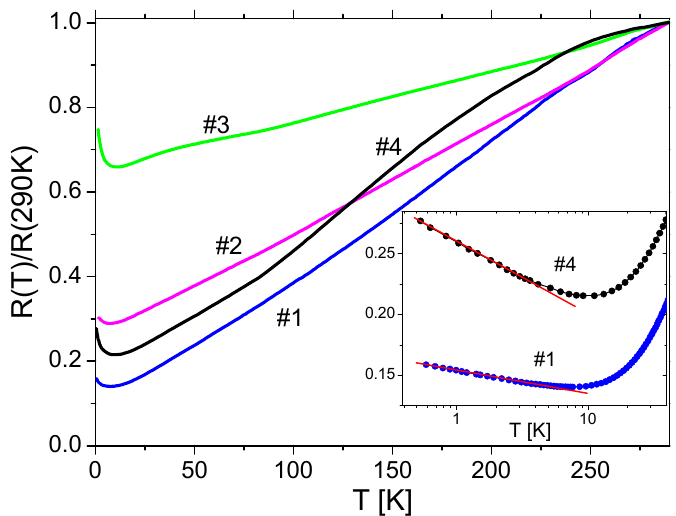
Figure 8. The temperature dependencies of the out-of-plane resistance R ⊥ (T) for crystals 1 – 4 . The R(290K) values are 287 Ohm, 3.77 kOhm, 2.52 kOhm, and 427 Ohm, respectively. The inset shows the resistance R(T)/R(290K) as function of T in the logarithmic scale for the samples 1 and 4 .